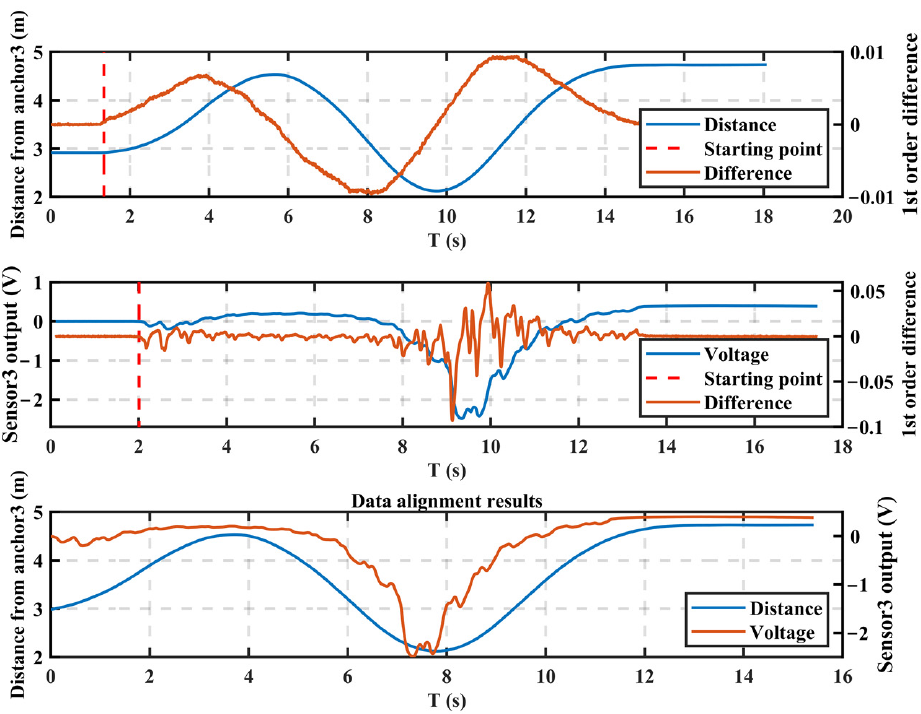
Figure 10. The alignment result of the electrostatic signal and the localization signal.